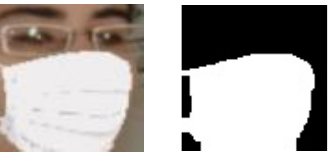
Figure 4. Examples for a pair of masked face image ( left ) and segmentation map image ( right ) that ( right ) that can be used to learn 𝐺 r . can be used to learn G r